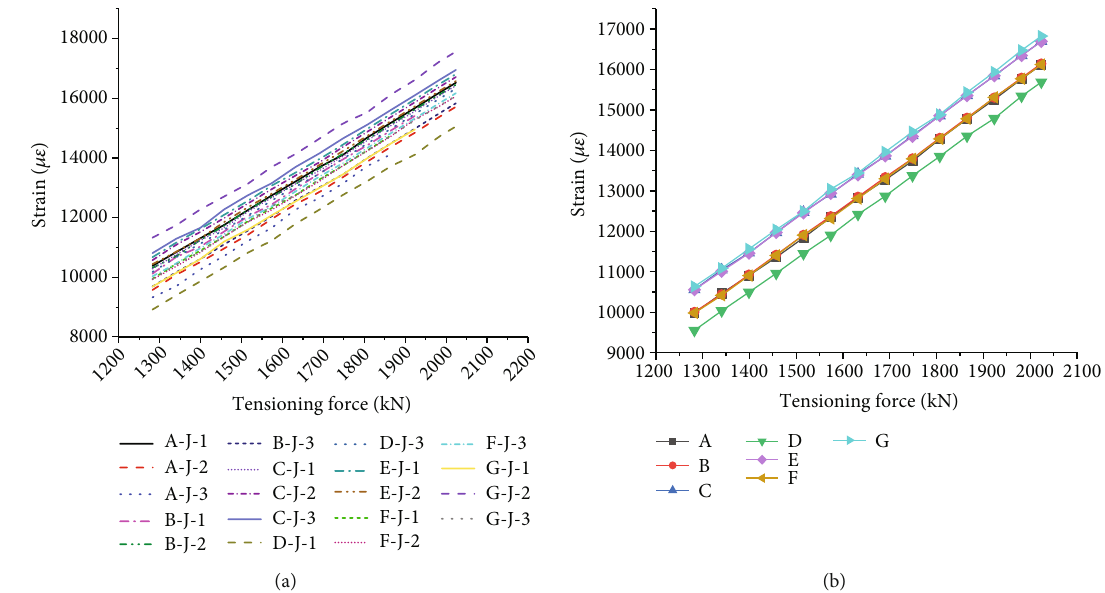
Figure 11: The relationship between the strain and the applied tensioning force for this large-tonnage BFRP anchor cable in the stage of the system tensioning: (a) all the BFRP tendons and (b) average of the BFRP tendons for each bunch of the “ BFRP-connector-strand.